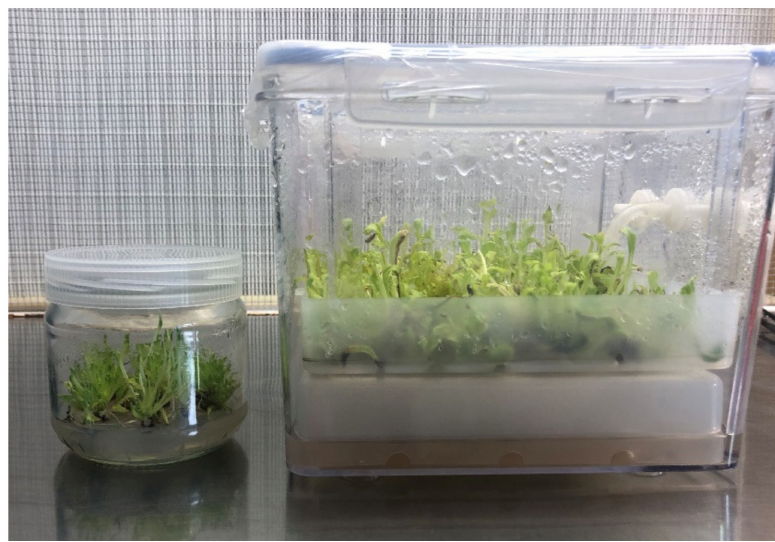
Figure 1. M. maritima in vitro culture in jars (left) and Plantform™